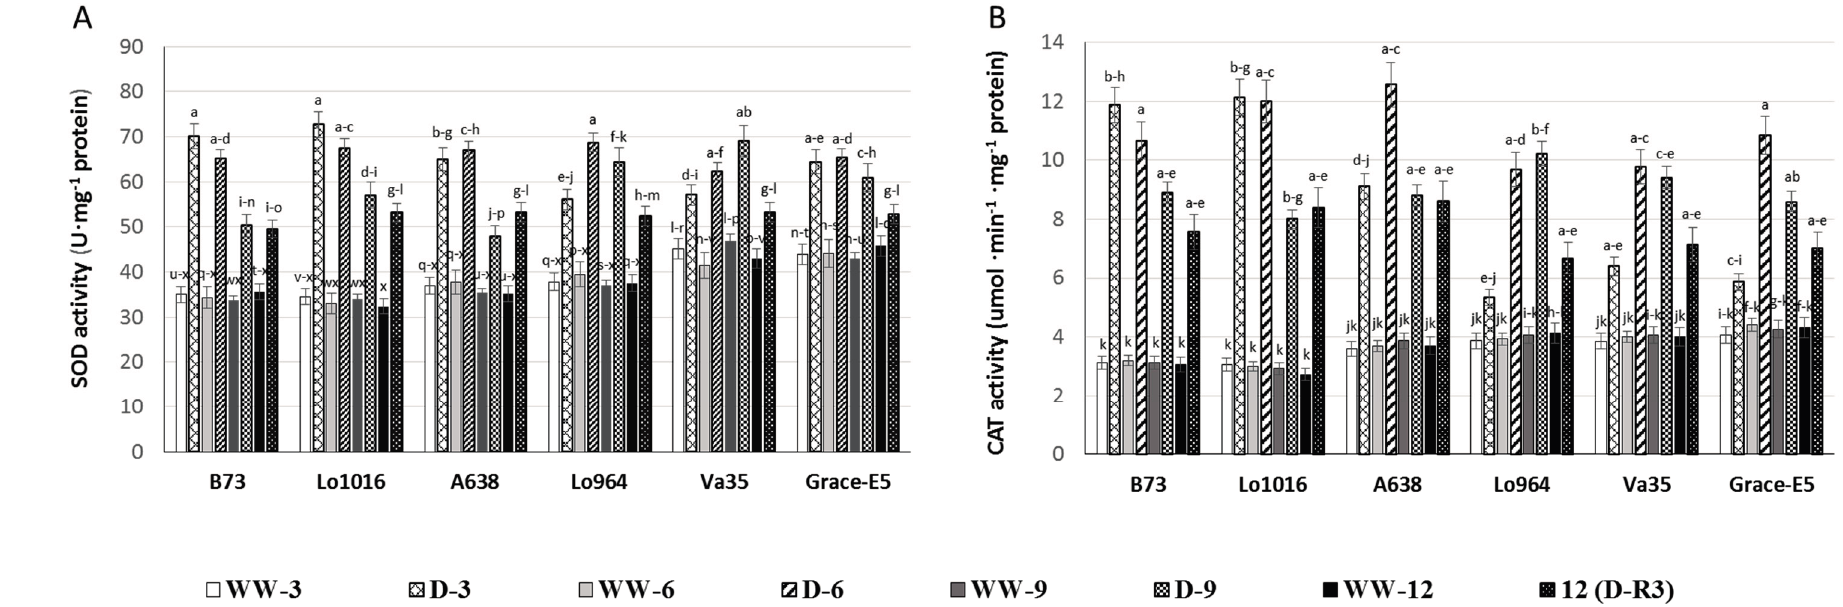
Figure 4. Effects of drought treatments on SOD and CAT activities in maize seedling leaves. The activities of ROS-remediating enzymes were measured in sensitive and tolerant genotypes over drought stress and recovery including SOD ( A ) and CAT ( B ). Different letters indicate significant differences ( p < 0.05) based on Tukey’s test between control and treatments and between different treatment times. Data represent the mean ± SD of three or more